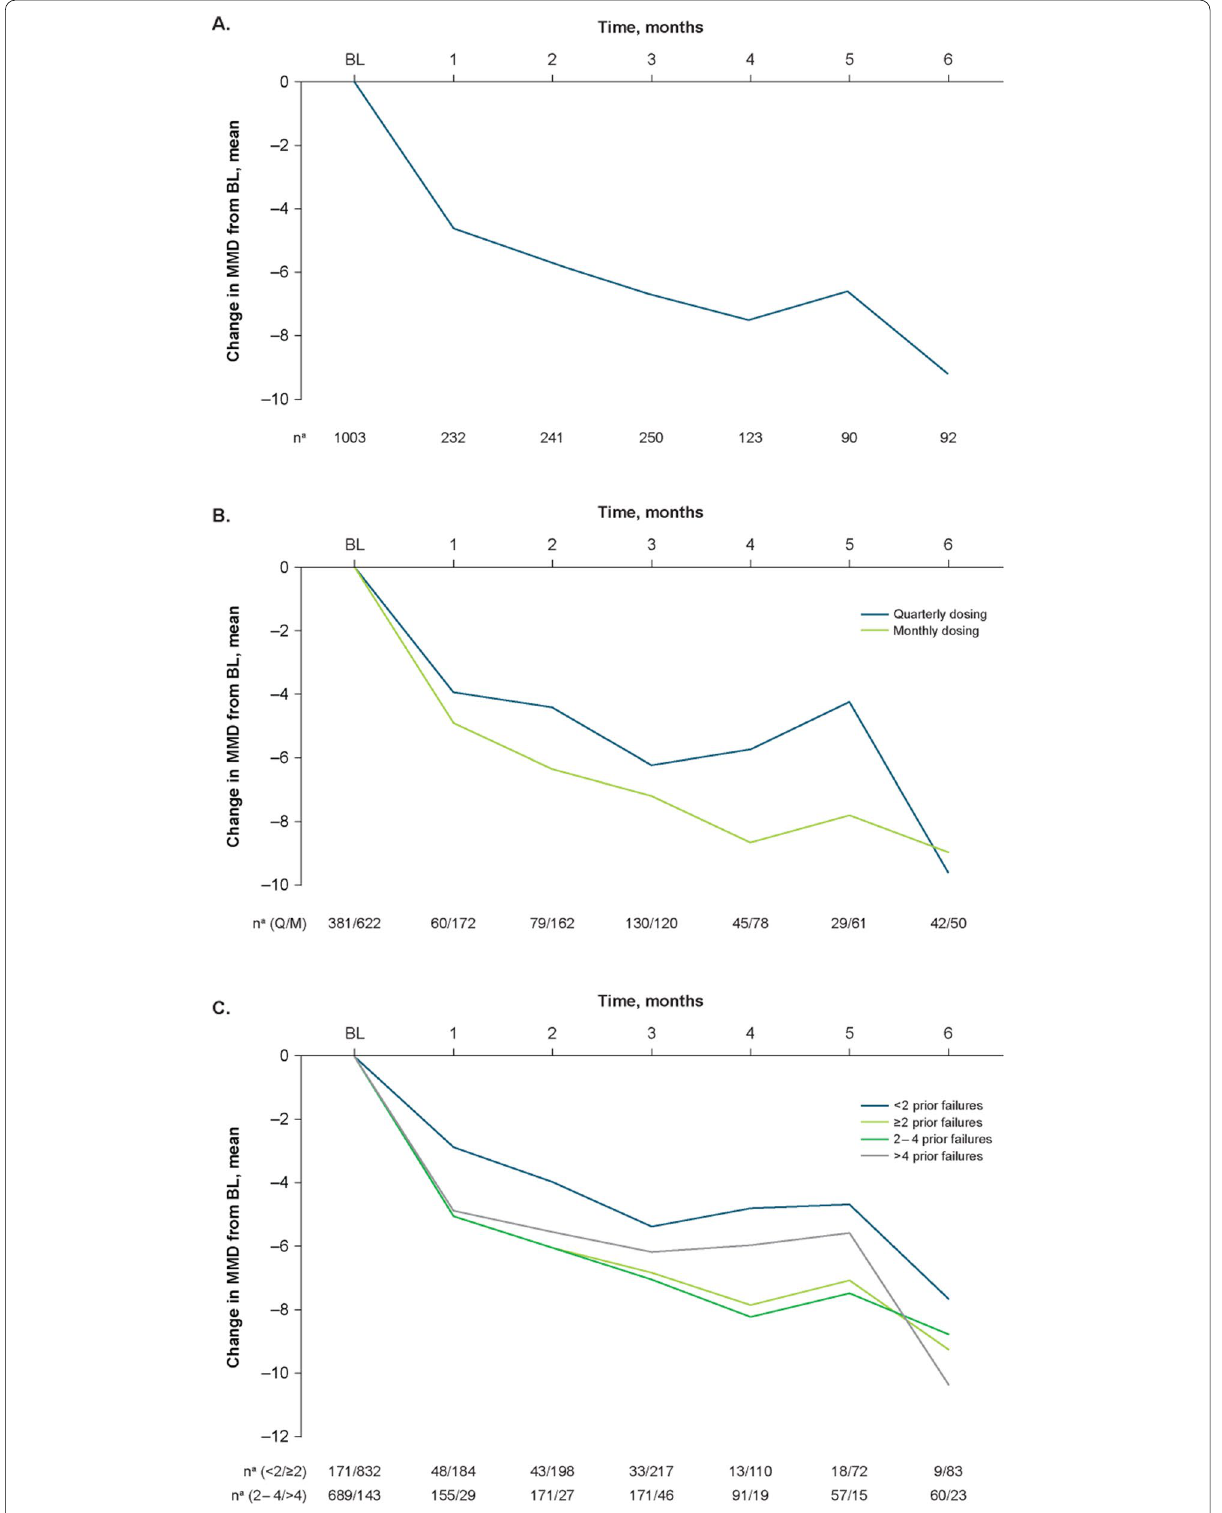
Fig. 2 Effectiveness outcomes by change from baseline in MMD: A ) total population; B ) dosing schedule subgroups; C ) prior treatment failures subgroups. BL, baseline; MMD, monthly migraine days; Q, quarterly; M, monthly. a Number of patients with available assessment at each time